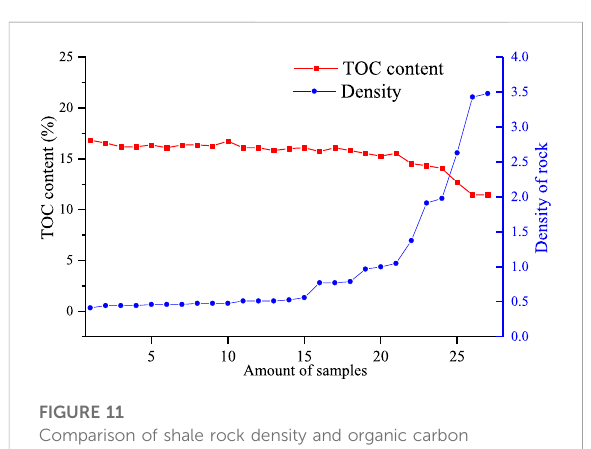
FIGURE 11 Comparison of shale rock density and organic carbon content in the upper part of the Lucaogou Formation.